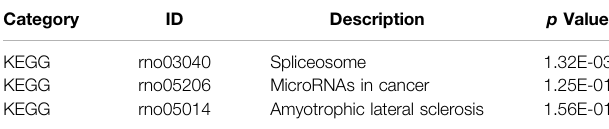
TABLE 2 | KEGG enrichment analysis.